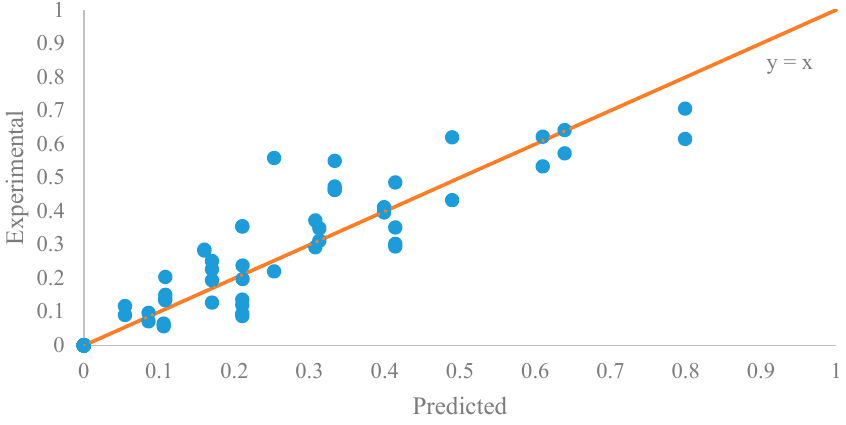
Figure 10. The parity plot of the data of the initial period (0–20 min).